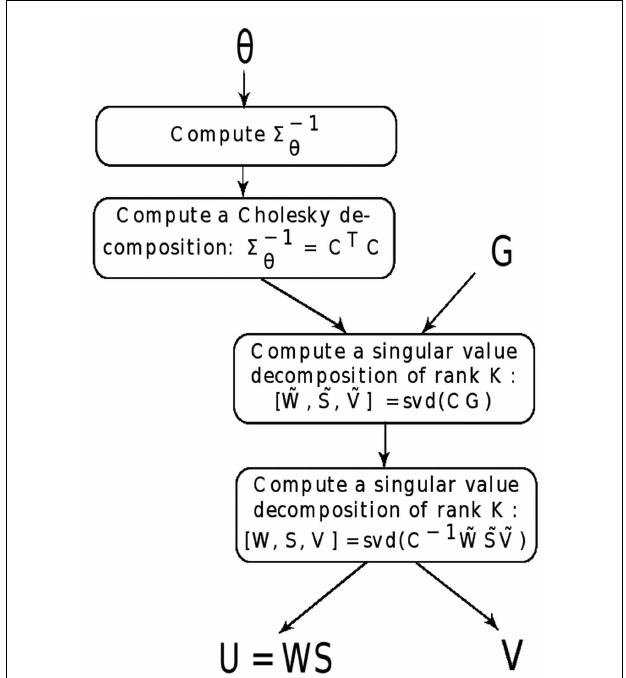
FIGURE 1 |Algorithm for spFA. For a genotypic matrix G with individual geographic coordinates ( X i ), and for scale parameter θ > 0, the spFA steps summarize as